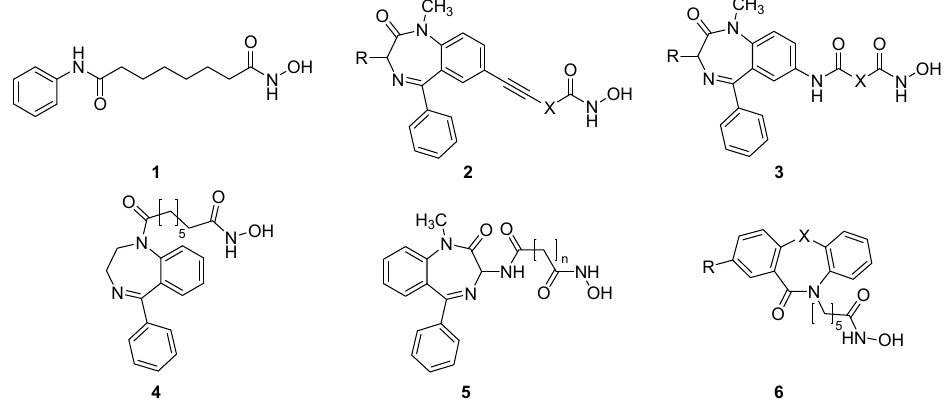
Figure 1. Vorinostat ( 1 ) and its analogues 2 – 6 based on benzodiazepine